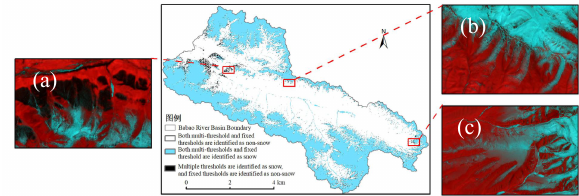
Figure 10 . Spatial differences in snow cover extraction results: (a) forest area; (b) transition area; (c) thin snow cover area.